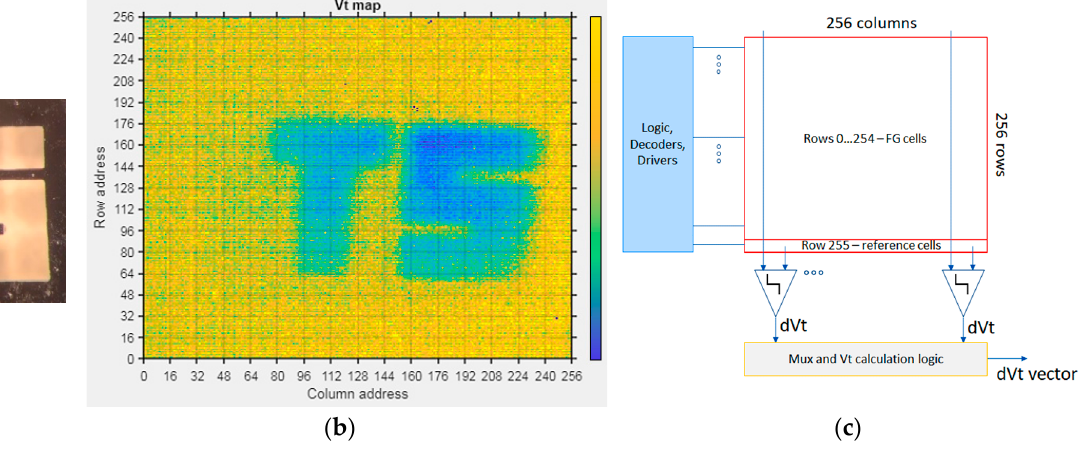
Figure 10. ( a ) Si template used for UV irradiation. ( b ) FG UV sensor matrix after exposure to 280 nm UV. ( c ) Schematic diagram of the read-out of FG sensor array.